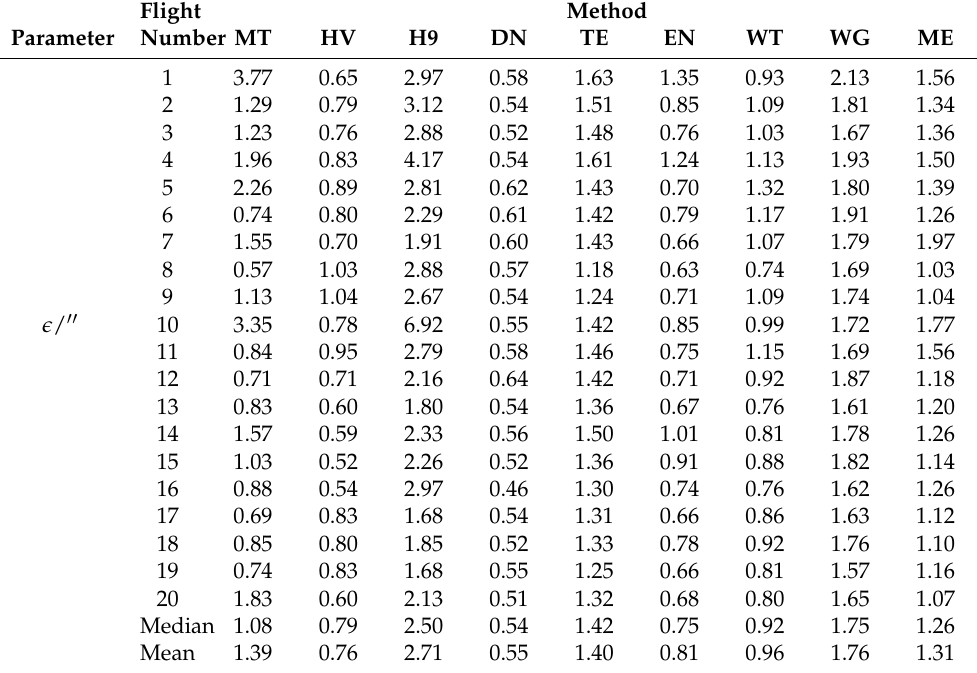
Table A8. NCACN integrated astronomical parameters details ( (cid:101) @ λ = 550 nm).